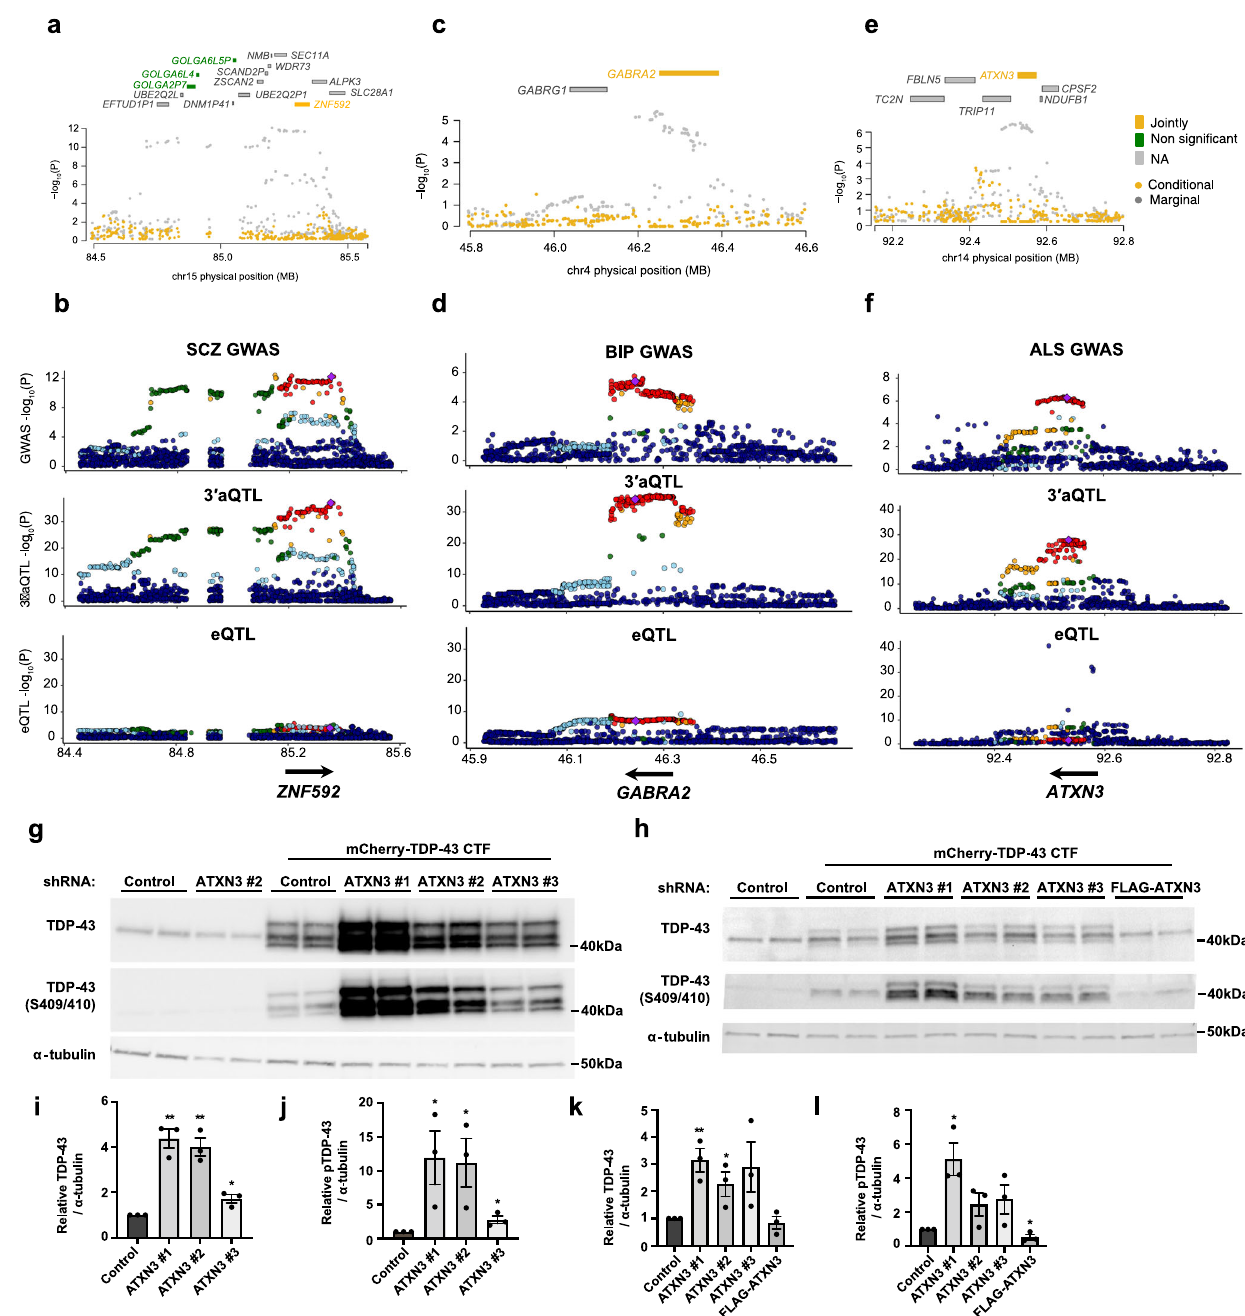
Fig. 5 | 3 ′ aTWAS identi fi es new APA-linked susceptibility genes in brain dis- orders.a Regionalassociationplot.SCZGWASsignalatthe ZNF592 locus(gray)and GWAS signal after removing the effects of ZNF592 3 ′ UTR usage (yellow). This ana- lysis shows that the association is largely explained by ZNF592 3 ′ UTR usage. b Aligned Manhattan plots of SCZ GWAS, 3 ′ aQTLs, and eQTLs at the ZNF592 locus. SNPsarecoloredbyLD( r 2 ). c Similarto( a )forthe GABRA2 locusinBIP. d Similarto ( b )forthe GABRA2 locusinBIP. e Similarto( a )forthe ATXN3 locusinALS. f Similar to( b )forthe ATXN3 locusinALS. g-h WesternanalysisofHEK293Tcells( g )andSH- SY5Y cells ( h ) transfected with mCherry-tagged TDP-43 CTF (aa 208 – 414) and shRNAs for 48h. Note: Multiple bands re fl ect distinct cleavage products. TDP-43 was detected using an antibody that recognizes a C-terminal epitope. i Quanti fi cationoftotalTDP-43inHEK293TcellstransfectedwithATXN3shRNA#1